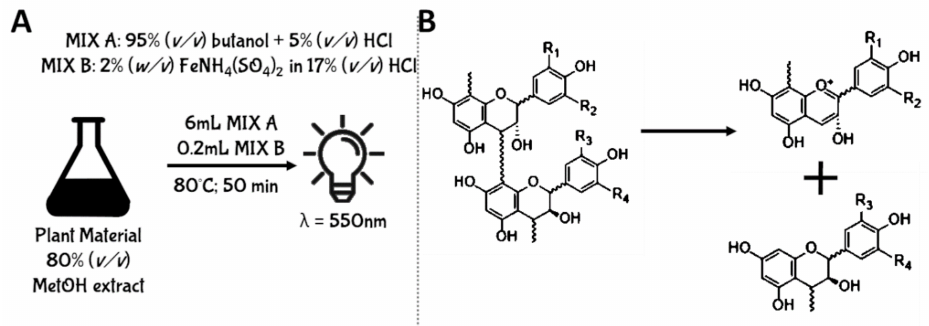
Figure 8. Schematic representation of Acid Butanol Assay for the quantification of PACs. Panel ( A ) displays the experimental protocol; Panel ( B ) displays the chemical reaction that allows the formation of the carbocation that spontaneously and quickly arrange in the respective